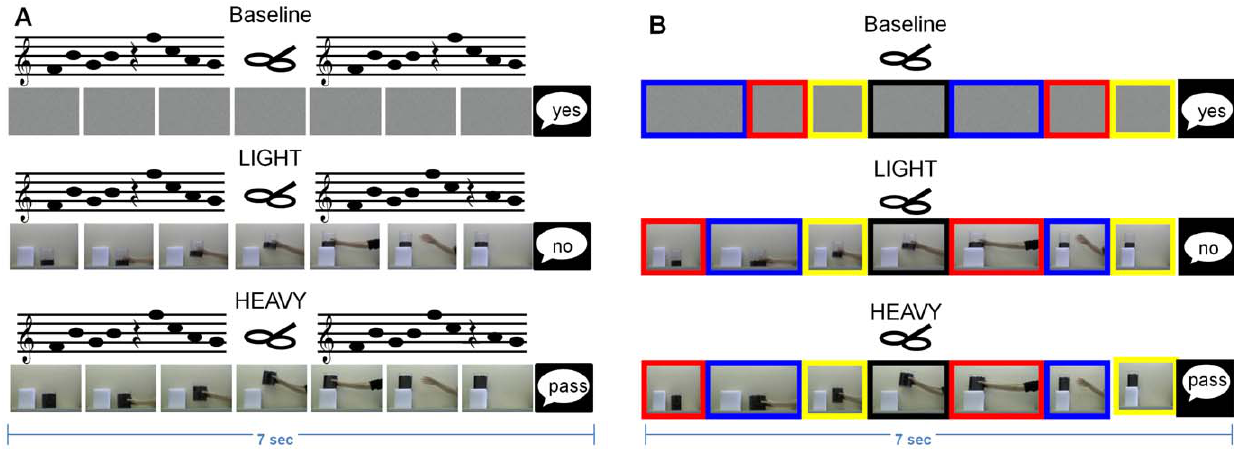
Figure 1. Video clips and discrimination tasks of experiments 1 and 2. Both experiments used the same 3 different video clips: baseline (top), light (middle) and heavy (bottom). Movement observation was presented together with an auditory discrimination task ( A , experiment 1) or a visual discrimination task ( B , experiment 2). The six different video sequences presented here represent one single trial with duration of 7 sec each. A In experiment 1, subjects had to discriminate two series of tones such that the position of one longer inter-tone-interval could either be identical ( A, top) or different ( A , middle). B In experiment 2, subjects had to discriminate to series of color changes of the rim. One of these colors was shown longer (as indicated by wider rectangles), however, the rhythm of the color change could either be identical ( B , top) or different ( B , middle). In both experiments, subjects had to say ‘‘yes’’ when the two series of tones/colors were identical, ‘‘no’’ when they were not identical, and ‘‘pass’’ when no decision could be made. The verbal response was provided after the video clip had finished. TMS was applied in between the two series of tone, when the object was lifted in the air, as symbolized by the TMS coil.